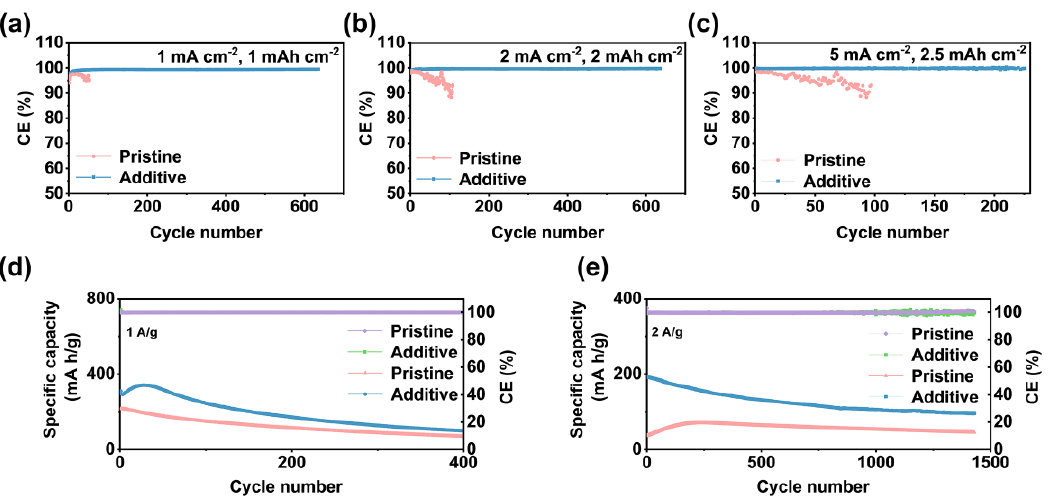
Figure 5. Electrochemical performance of Zn|Cu asymmetric cells and Zn|V 2 O 5 full batteries. ( a – c ) Zn|Cu asymmetric cells using pristine electrolyte and additive-containing electrolyte when the current density is 1 mA cm − 2 , 2 mA cm − 2 , and 5 mA cm − 2 . ( d , e ) Zn|V 2 O 5 full batteries with pristine electrolyte and additive-containing electrolyte when the current density is 1 mA cm − 2 and 2 mA cm − 2 .